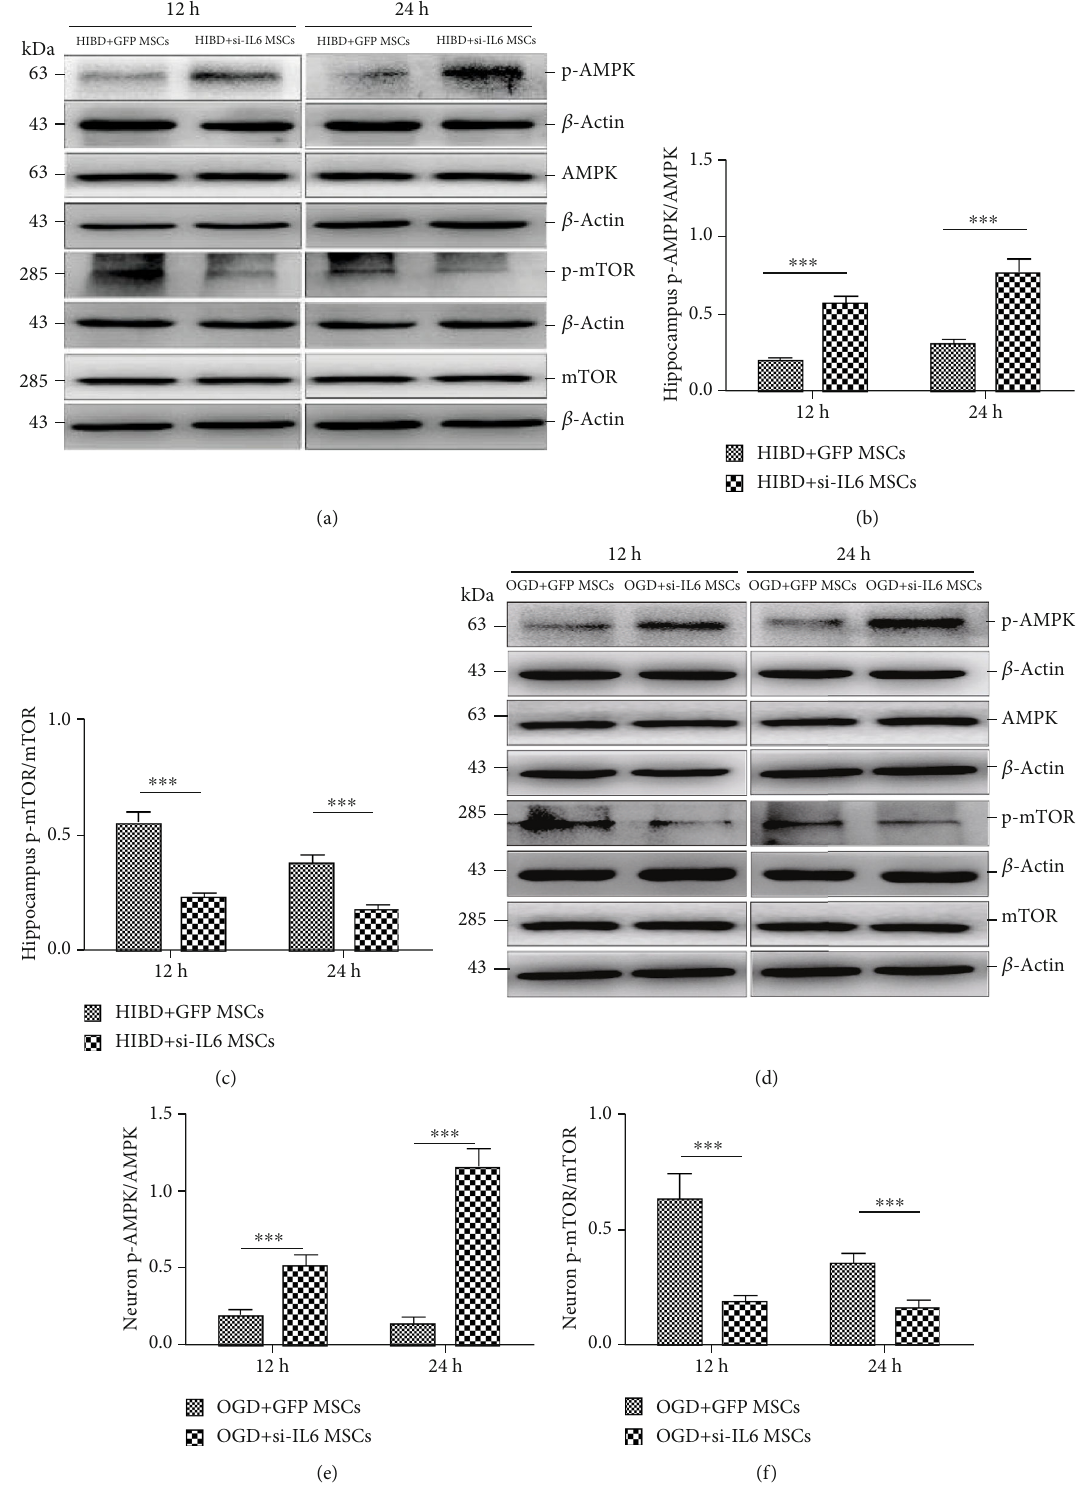
Figure 6: siIL-6 MSC transplantation increased hippocampal neuron p-AMPK protein expression levels and decreased p-mTOR levels following damage for 12 h and 24 h. (a) Representative western blots of hippocampal p-AMPK, AMPK, p-mTOR, and mTOR protein expression levels in the HIBD+siIL-6 MSC and HIBD+GFP MSC groups. (b, c) The ratio of p-AMPK/AMPK and p-mTOR/mTOR protein expression levels in the hippocampus ( n = 7 , ∗∗∗ P < 0 : 001 ). (d) Representative western blots of the p-AMPK, AMPK, p-mTOR, and mTOR protein expression levels in the OGD+siIL-6 MSC and OGD+GFP MSCs group. (e, f) The ratio of p-AMPK/AMPK and p- mTOR/mTOR protein expression levels in the two groups ( n = 6 , ∗∗∗ P < 0 : 001